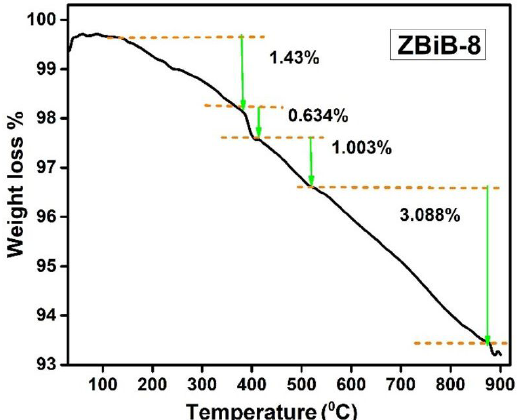
Figure 2. TGA curve for ZBiB-8 glass while heating in the temperature range of 50-900